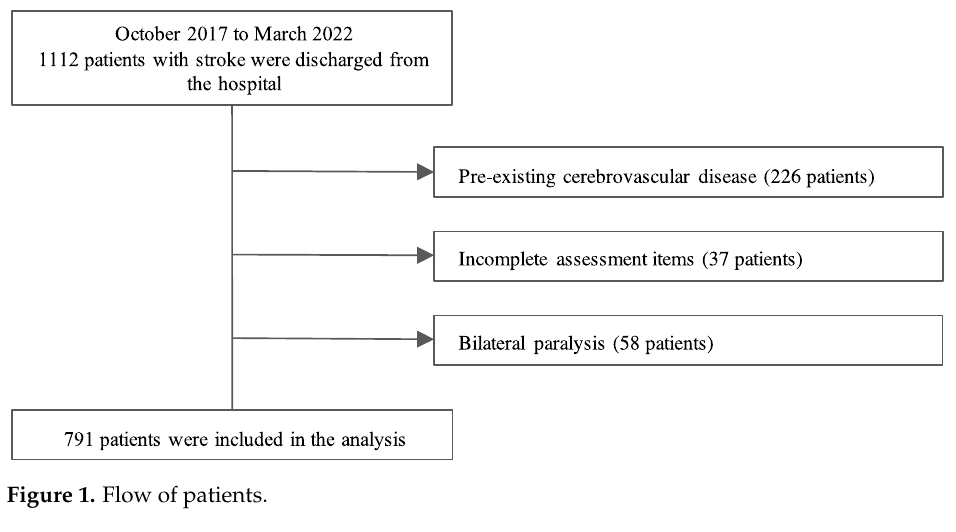
Figure 1. Flow of patients.